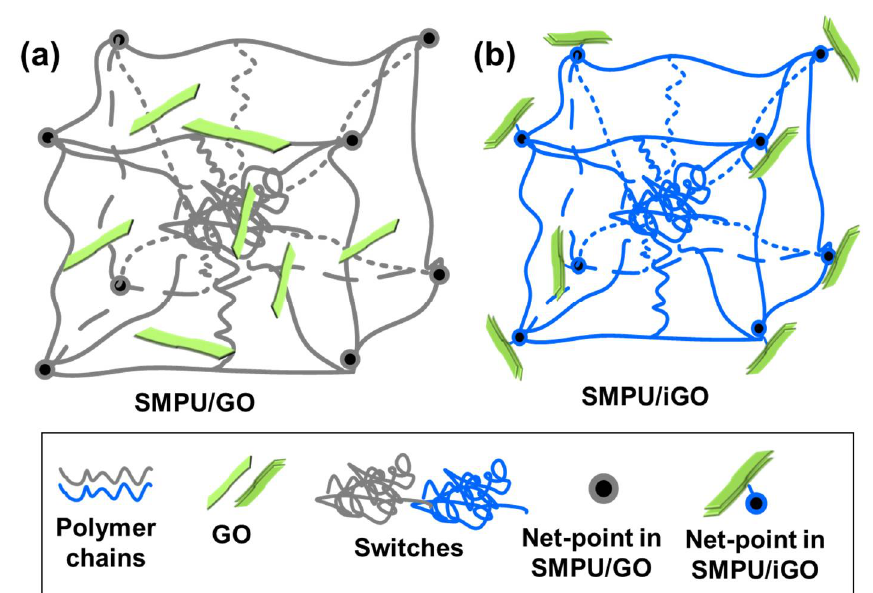
Figure 6. Structural models of the SMPU composites: ( a ) SMPU/GO, and ( b ) SMPU/iGO.